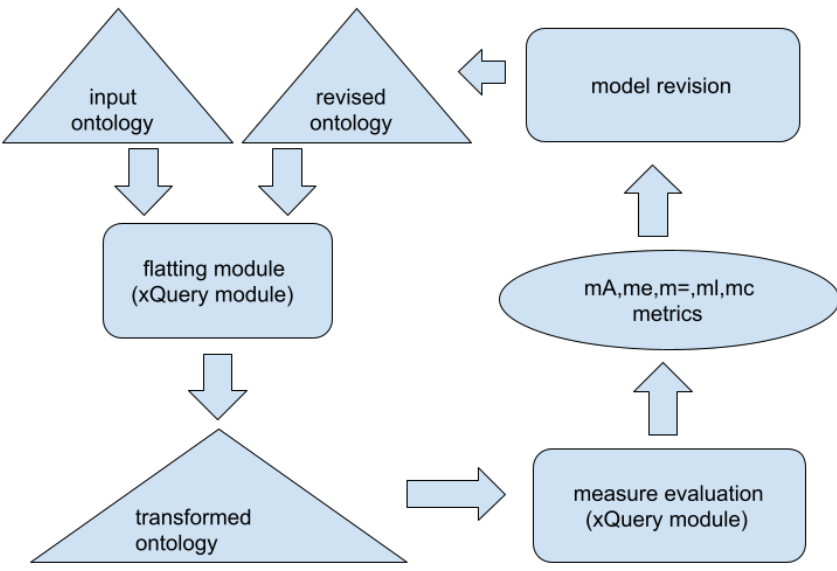
Figure 1. Architecture of the evaluation